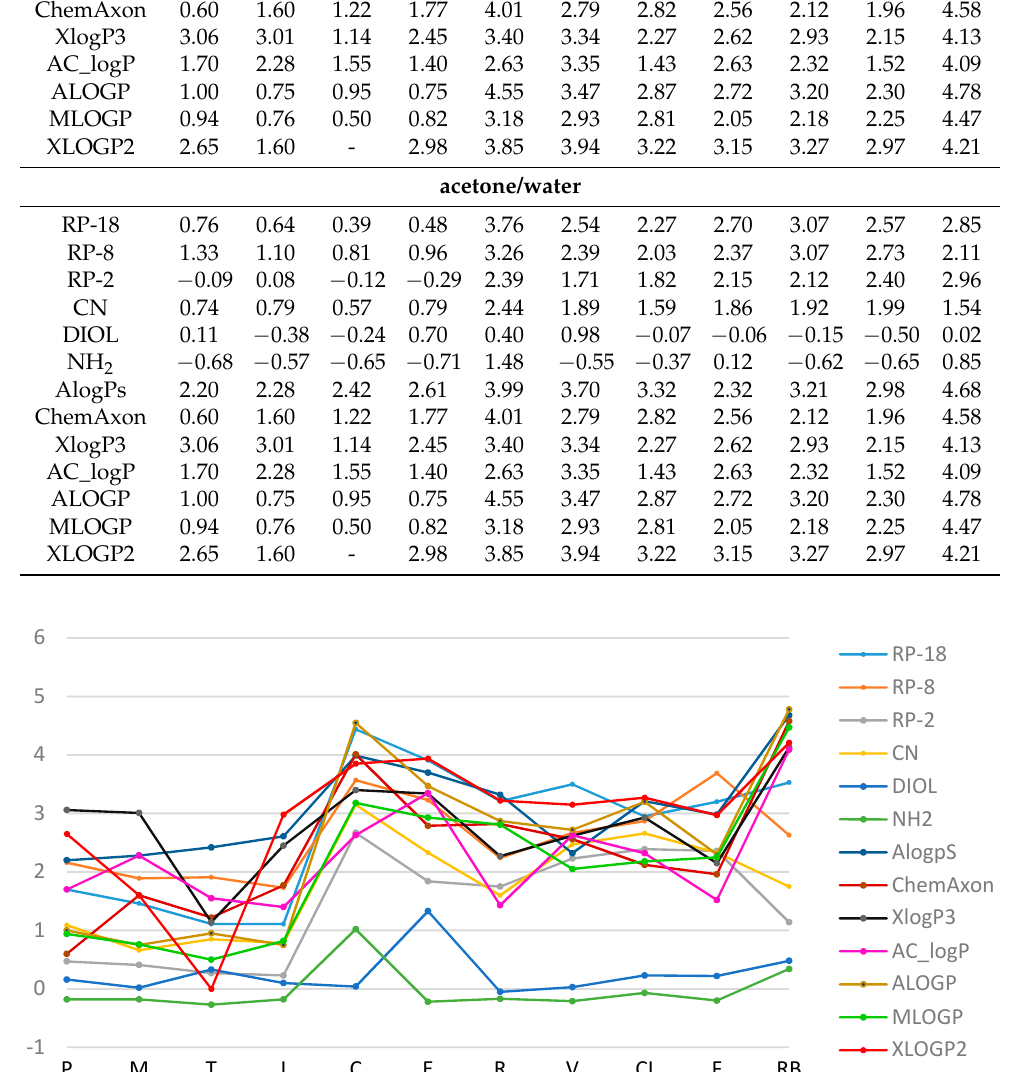
Figure 4. A plot of the relationship of R M0 values for the tested substances obtained experimentally (in the acetone/water mobile phase) and by calculation methods. In most cases, the calculated values are higher than those determined experimentally. The highest values of logP calc were obtained using XlogP3, XlogP2 and AlogP, while the lowest were obtained experimentally, on silica gel plates modified with DIOL and NH 2 groups (for both organic modifiers). The highest logP calc values were obtained for RB and C, while the lowest values were obtained for all oxicams. A fairly large variation in logP calc values was observed, especially for C and RB; the smallest differences were found with T. Moreover, for all coxibs, the results obtained on DIOL and NH 2 plates ranged from − 0.65 to 1.48, and differed from the other values obtained on RP and CN plates and by calculation methods (values in the range from 1.43 to 4.78).